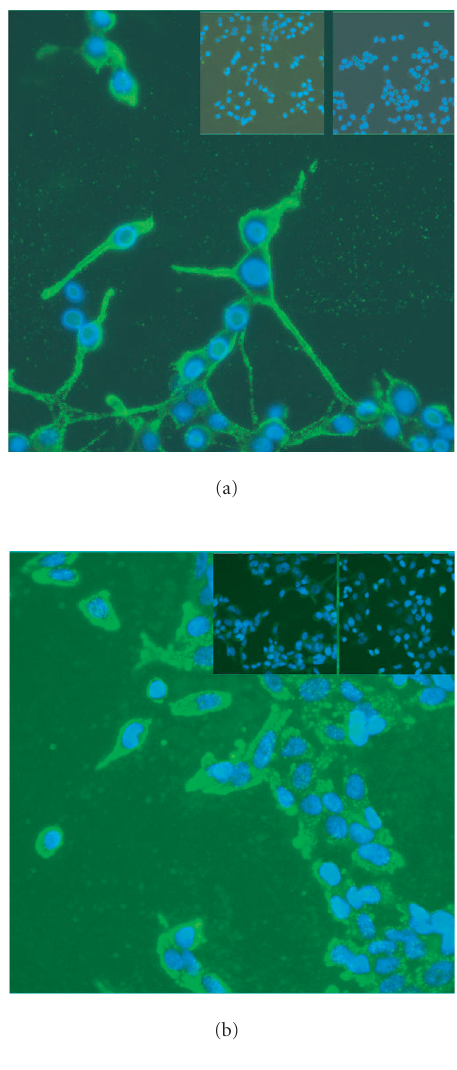
Figure 4. Specific attachment of recombinant Bv to mammalian cells. 3T3 cells (a) and prostate epithelial cells PNT1A (b) were infected with > 100particles/cell with a humanised Bv for 1hour at 4 ◦ C to permit attachment but not penetration. The cells were then fixed and stained with an antibody against the Bv gp64 pro- tein. Controls are shown in the inserts (no virus infection and no primary antibody). Note the even coating of the 3T3 cells and the patchy but strong staining of the PNT1A cells.